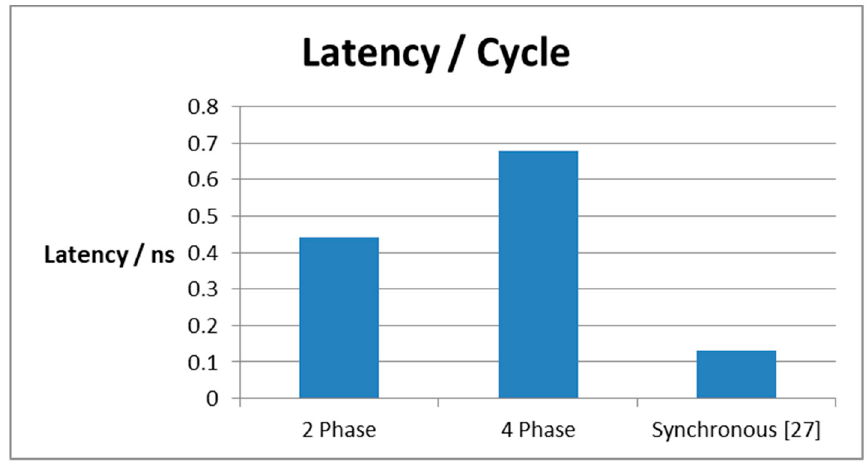
Figure 11. The latency comparison among the three protocols under uniform random traffic for a circuit-switched NoC.